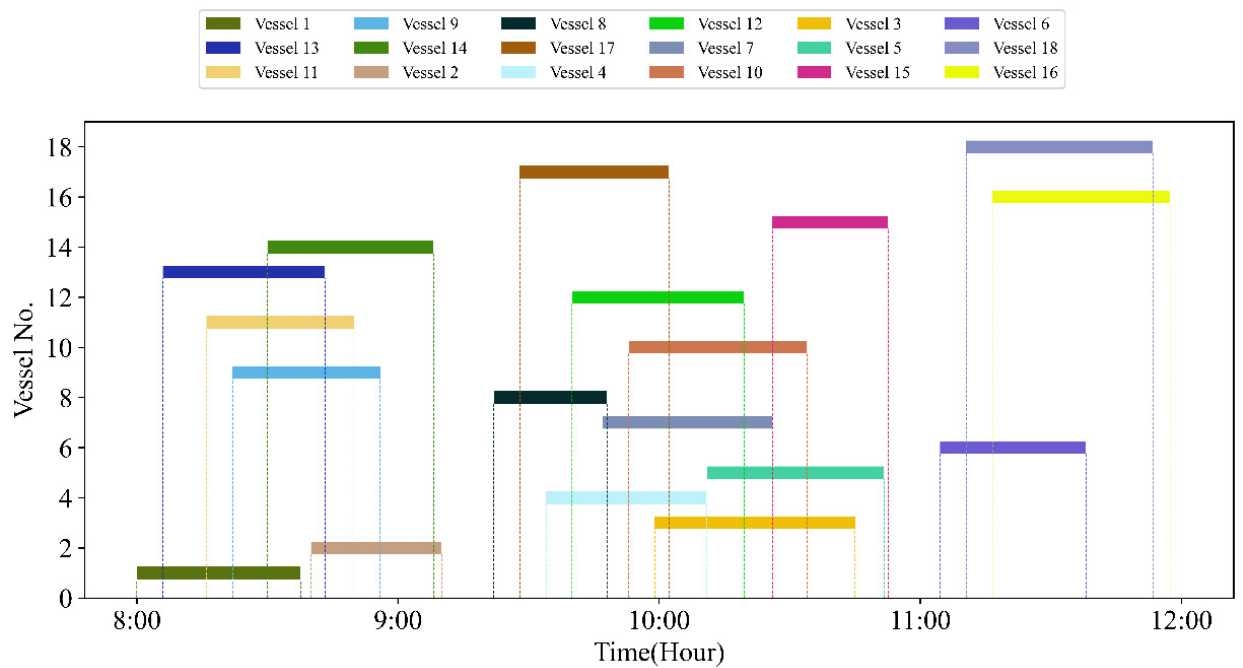
Figure 13. Gantt diagram of the optimization result of “Inst_18_1”.